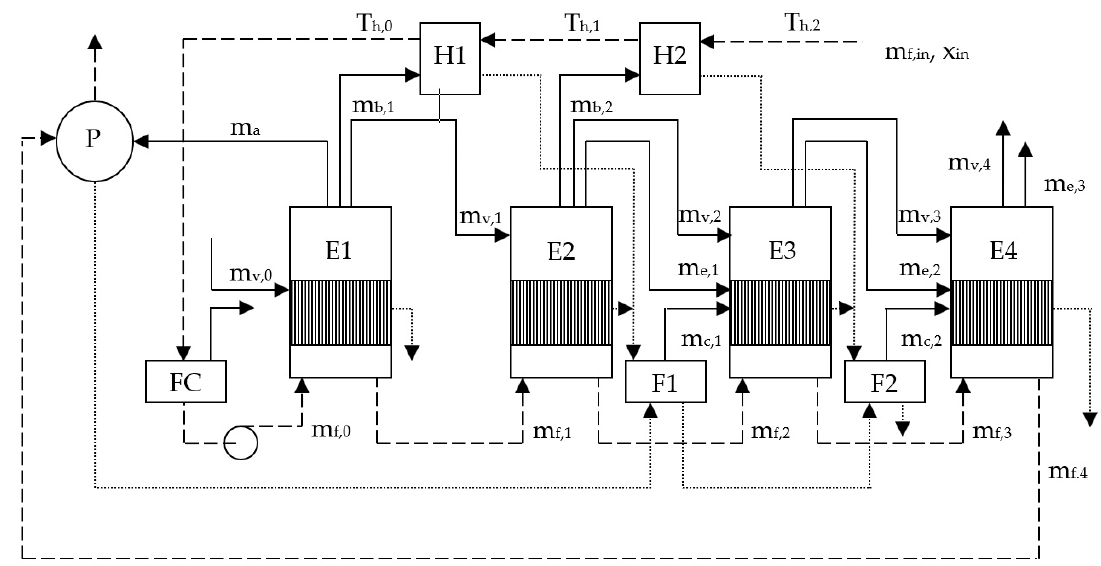
Figure 1. Forward-feed multiple-e ff ect